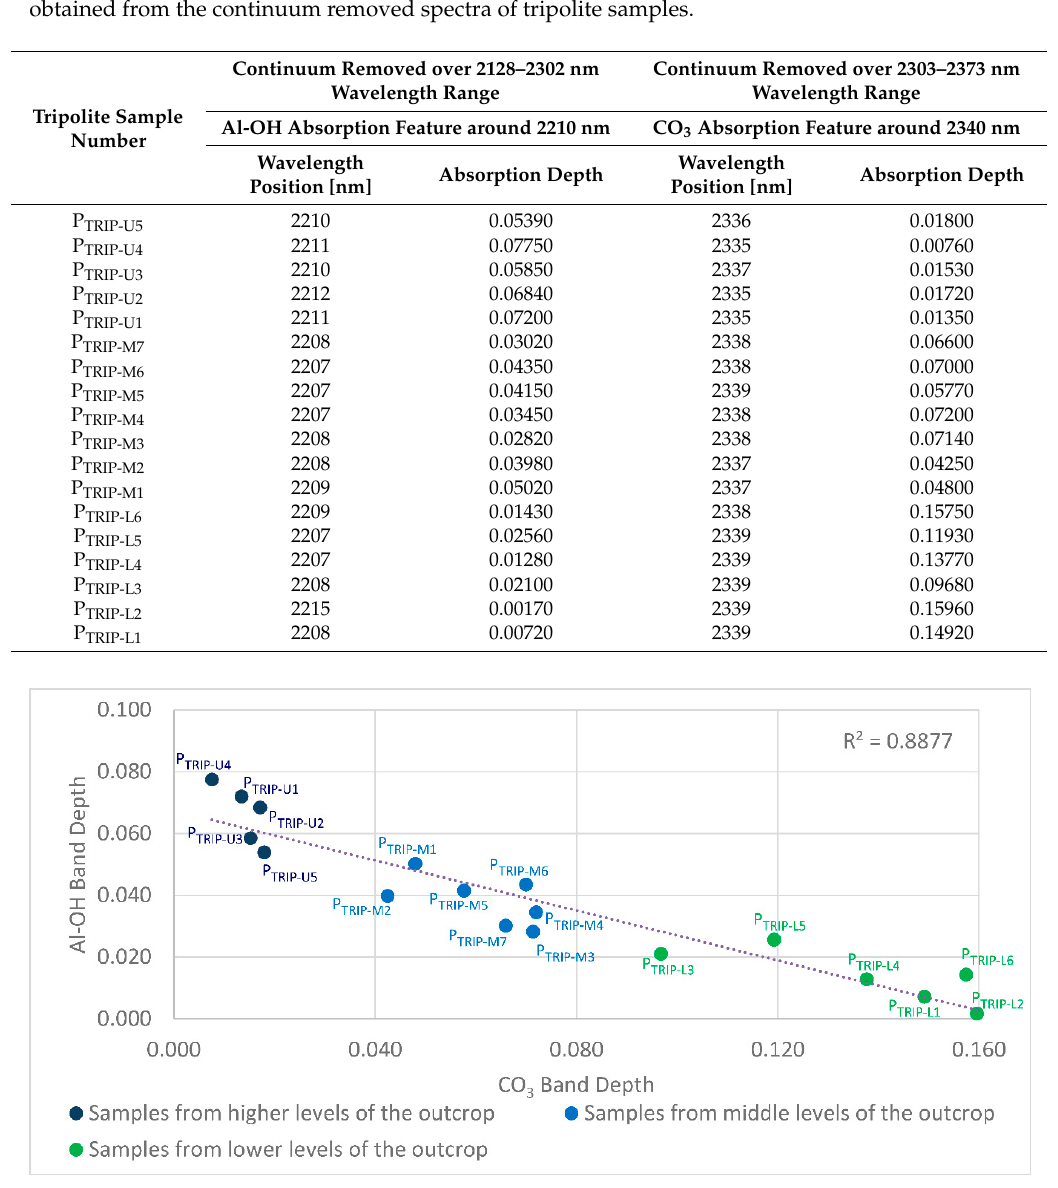
Figure 10. Relative Al-OH absorption feature depths versus relative CO 3 absorption depths from 18 tripolite samples collected from the investigated roadcut. The samples were divided into three clusters and color coded based on the levels they were collected.